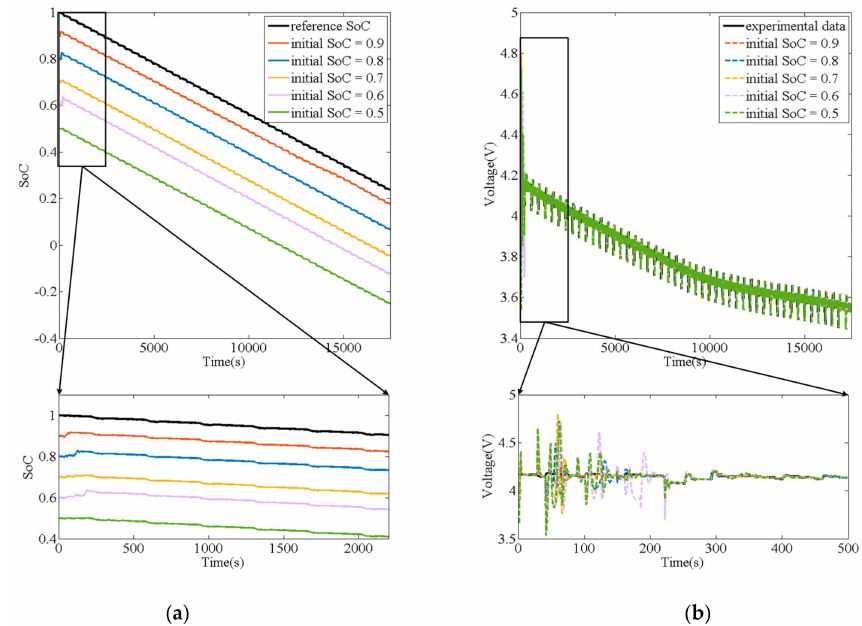
Figure 20. ( a ) The comparison of the convergence performance of SoC estimation between di ff erent initial value of SoC using AUKF-UKF under DST test; ( b ) The comparison of the convergence performance of u L prediction between di ff erent initial value of SoC using AUKF-UKF under DST